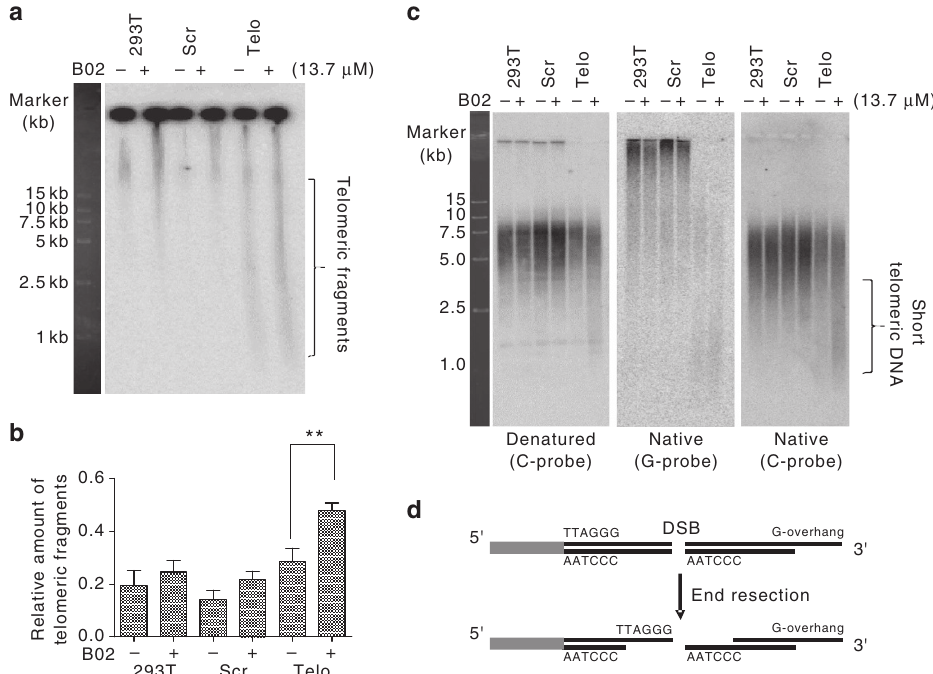
Figure 6 | Effect of B02 on telomeric DSBR. ( a ) Cells were treated and analysed as in Fig. 4a, with the addition of B02 (13.7 m M) as indicated. ( b ) Quantification of a , values are the average ± s.d. of three independent experiments. The signal intensity was quantified and normalized as described for Fig. 1c. ** P o 0.01. The Student’s t -test was used to determine the statistical significance. ( c ) Cells were treated as in a . DNA was isolated and analysed using the in-gel hybridization assay. After electrophoresis, telomeric C-probe or G-probe was hybridized under native or denaturing conditions. ( d ) Schematic diagrams show hypothesized repair of DSBs in